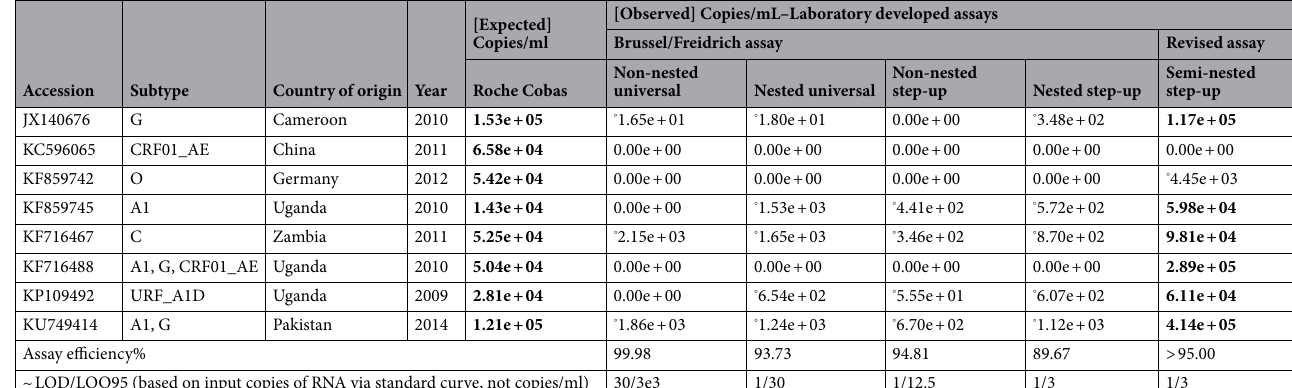
Table 1. Effect of nested PCR, step-up cycling, and oligonucleotide sequence on cross-subtype specificity and accuracy of HIV-1 RT-qPCR LDAs. NB: This table includes a selection of 8 HIV-1 strains that were difficult to quantify using the Brussel/Freidrich assay—496F/546P/622R1/633R2, compared to the performance of the revised 525F/574P/599R assay. 10 ng/ml tRNA was used in the mastermix, in all these experiments. ◦ Samples that were under-quantified by the LDAs; Bold type = Samples that were correctly quantified by the assays.